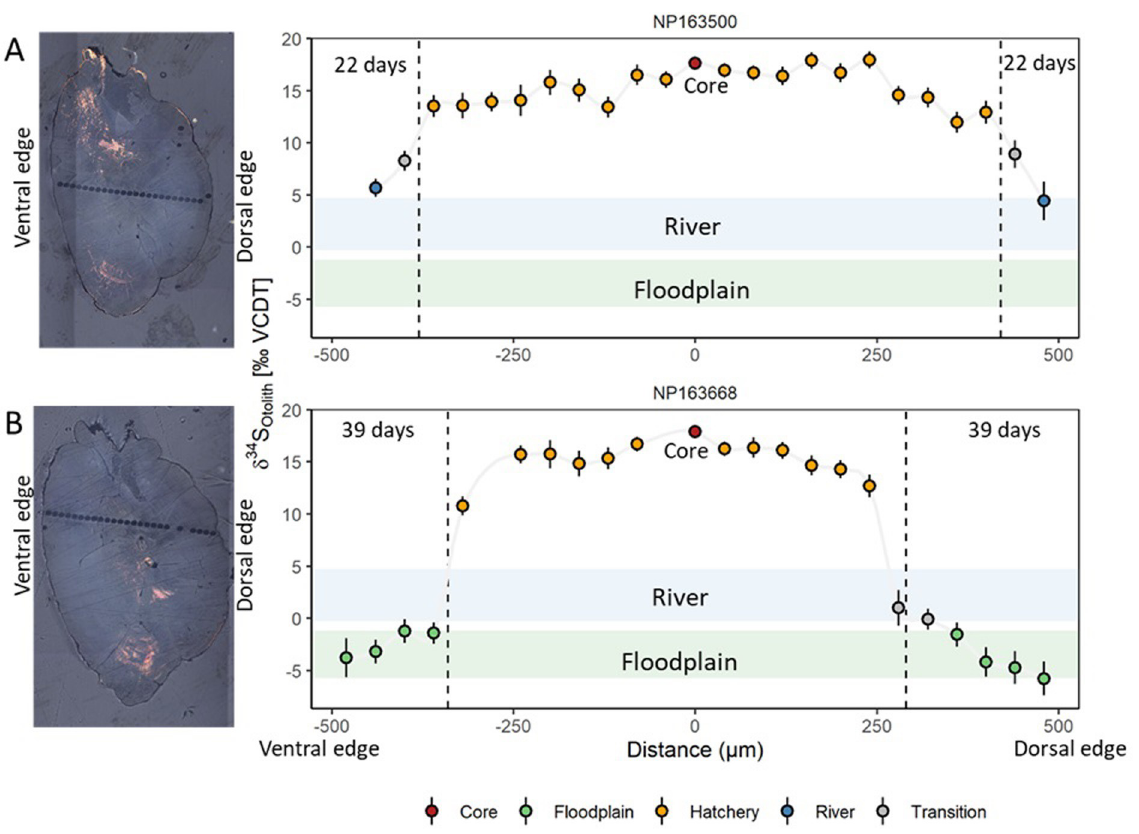
Fig 7. Example δ 34 S Otolith profiles for a fish reared on the river (A) and floodplain (B). Spots that overlapped the timing of movement from the hatchery to the river or floodplain were classified as “transition” and not included in the calculation for the δ 34 S Otolith means as they represent a mixture of otolith growth in different